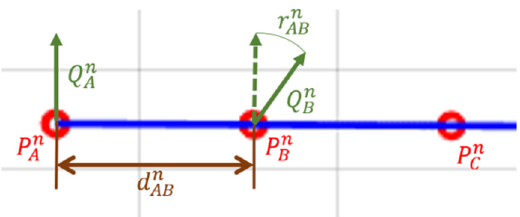
Figure 4. Mean error calculation for distances and orientation. The red circles represent the stops of the robot tool in the same repetition and during the trajectory shown in the image as the blue line.